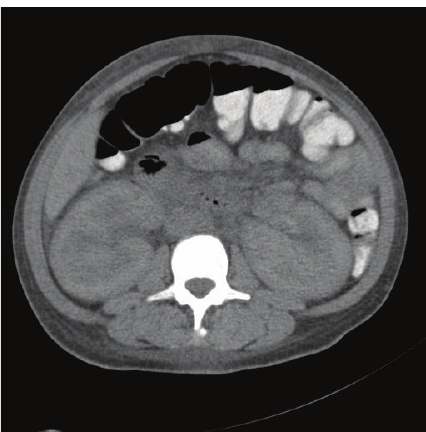
Figure 1: Computed tomography (CT) scan of the abdomen/pelvis without contrast revealing bilateral enlarged and edematous kid-